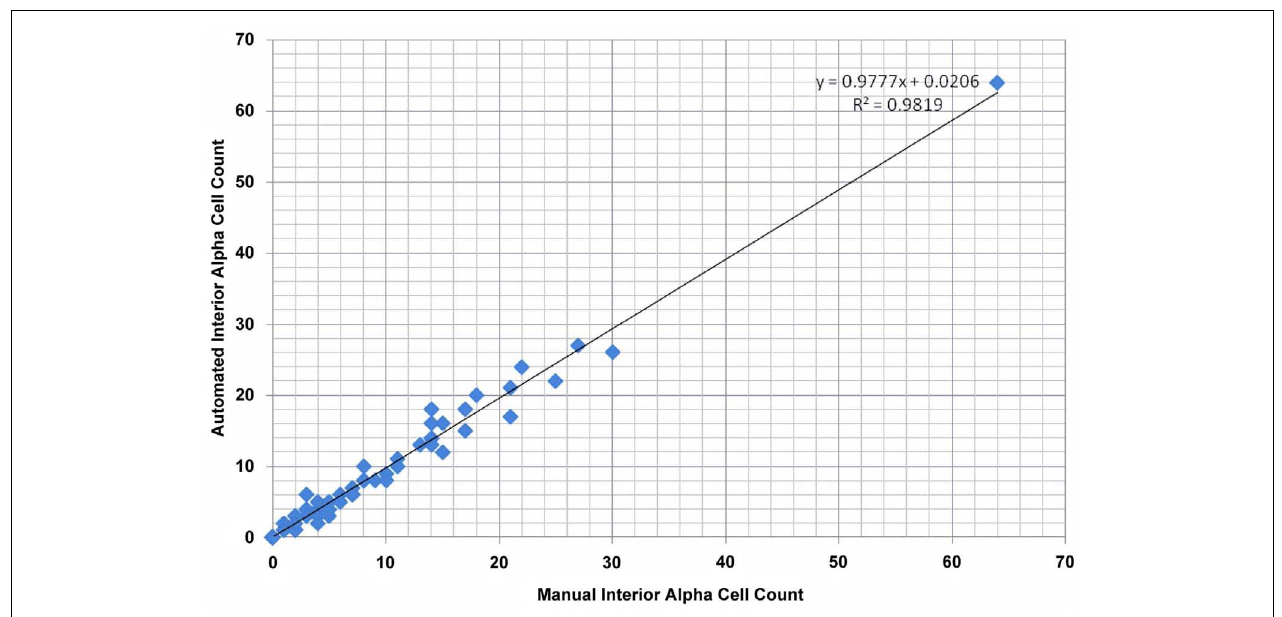
FIGURE 3 |Validation results for quantification of interior alpha-cells. Total size of validation set was 75.The Pearson’s correlation coefficient, p -value from Pearson’s Chi-square goodness of fit test, average absolute error, and average relative error were 0.9909, 1.7 × 10 − 7 , 0.8310, and 0.0158,